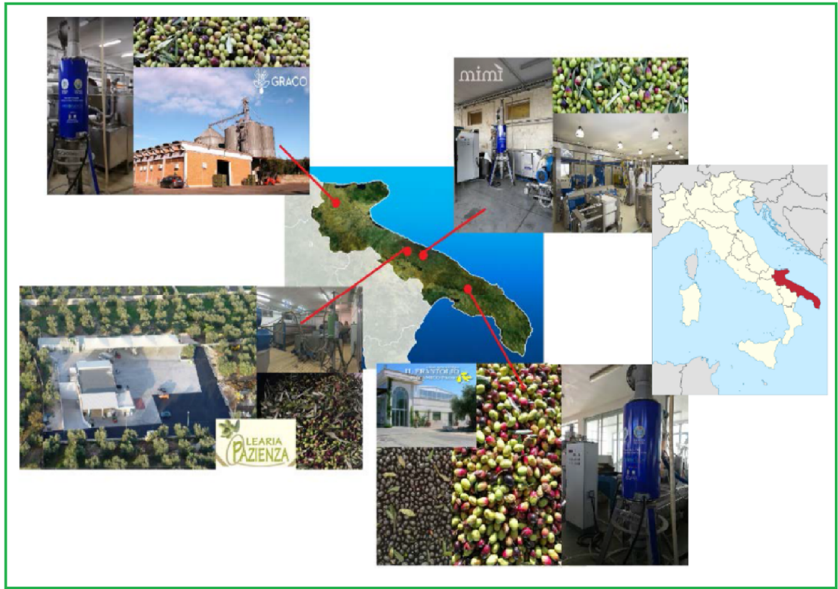
Figure 6. End-user validation of the industrial ultrasound application in the extra-virgin olive oil extraction process.